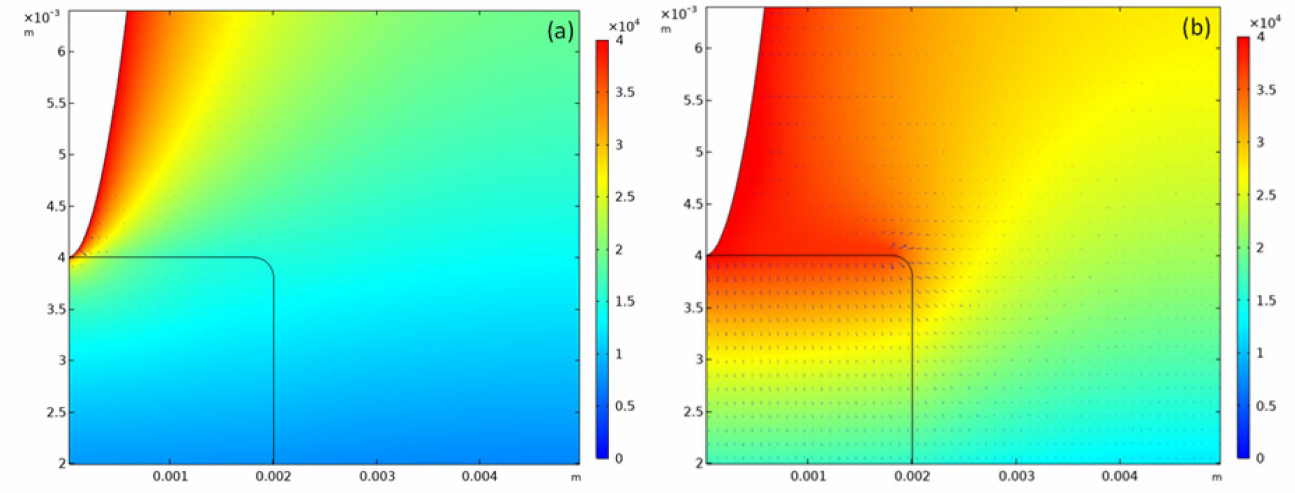
Figure 4. Potential distribution at the initial stage of discharge: ( a ) 0 ns; ( b ) 0.5